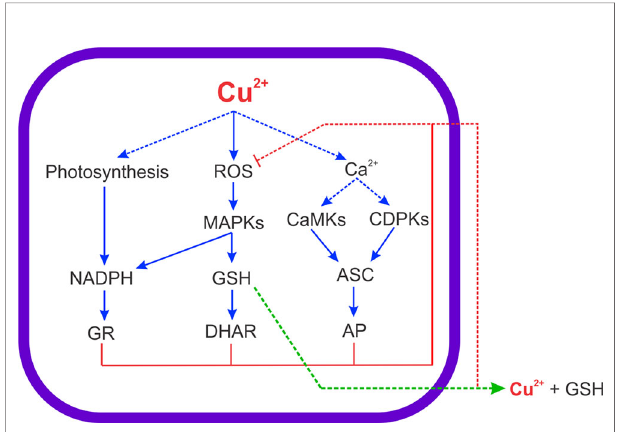
FIGURE 8 | Scheme of copper-induced increase in ROS and intracellular calcium levels leading to activation of MAPK, CDPKs and CaMKs signaling pathways, which coupled to the increase in net photosynthesis, allow the increase in ASC, GSH and NADPH levels to cope with copper-induced oxidative stress in the marine alga U. compressa . Arrows in blue indicate activation, arrows in red indicate inhibition, the arrow in green indicates extrusion, and choppy arrows indicate results that do not belong to this study.